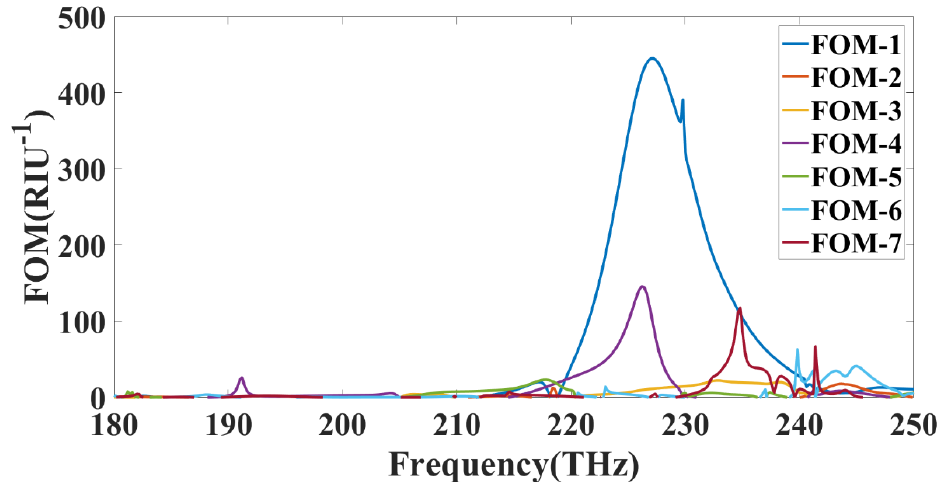
Figure 10. Variation in the electric filed distribution E (V/m) for peak resonance frequency values. Electric field distribution at ( a ) 191 THz, ( b ) 199.4 THz, ( c ) 209.8 THz, ( d ) 220.5 THz, ( e ) 233.4 THz, and ( f ) 236 THz. The refractive index of the analyte is considered 1.1 for this result.